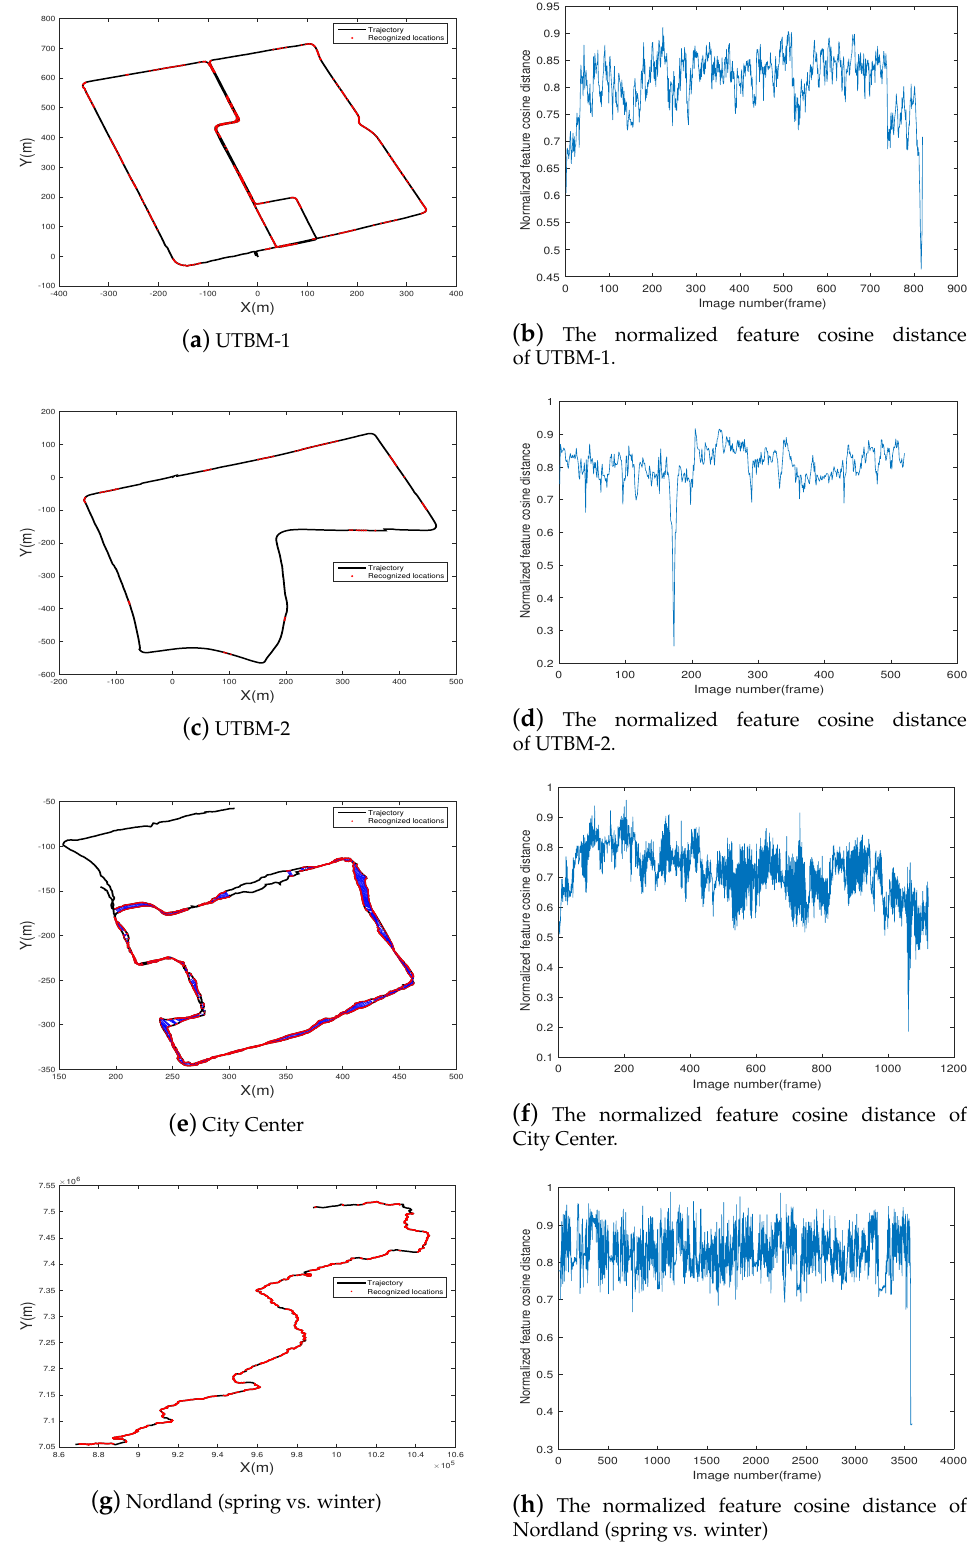
( h ) The normalized feature cosine distance of Nordland (spring vs. winter) Figure 16. The visual localization results in the four data sets. The used feature is 4096 hash bits of the conv4 layer. In the left column, two images from the same location (on the basis of appearance alone) are marked with red points and joined with a blue line. In the right column are the corresponding normalized feature cosine